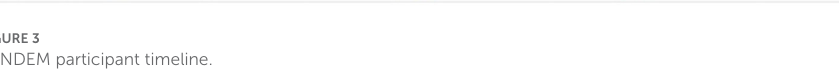
FIGURE3 TANDEM participant